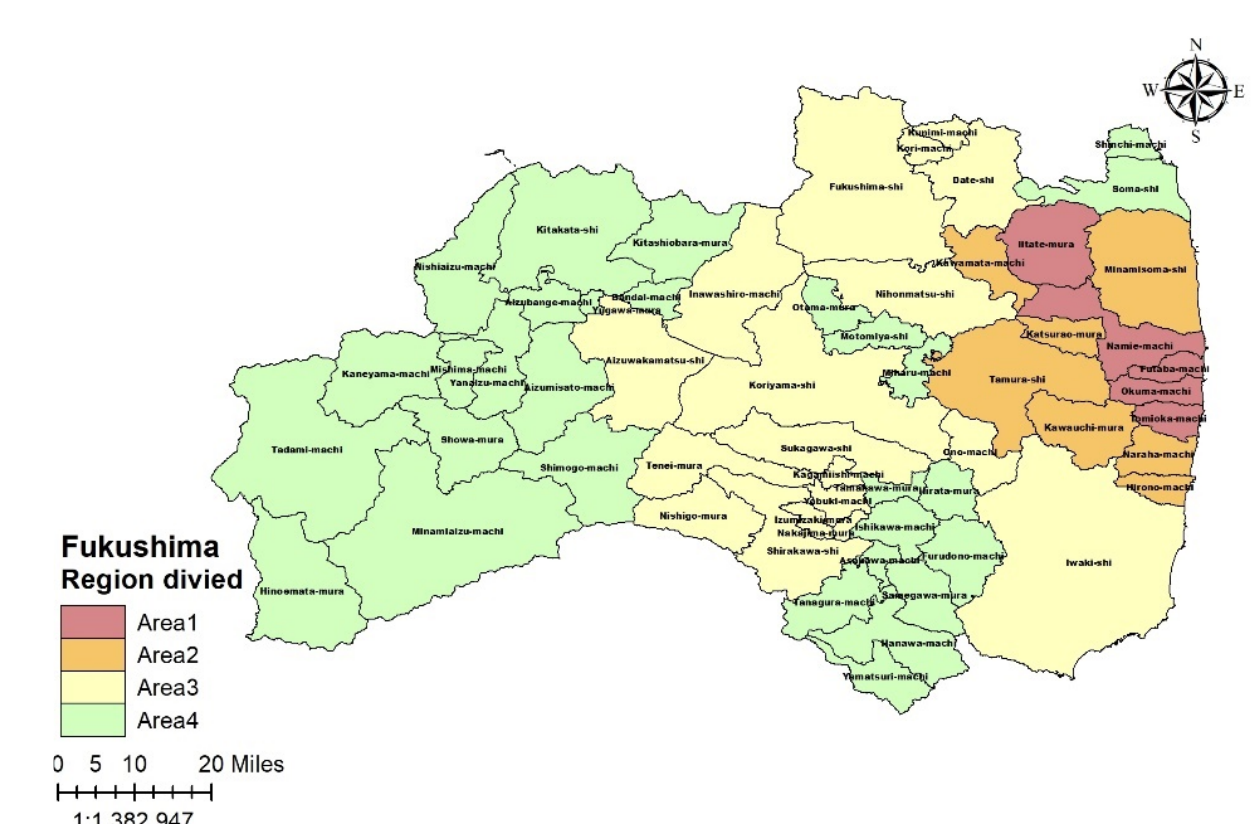
Figure 2. Group design based on the history of the Fukushima evacuation area and caution area. Area 1: still difficult to return at the time of the deadline; Area 2: where the evacuation alerts have been lifted at the time of the deadline; Area 3: near the evacuation area or with a history of voluntary evacuation; and Area 4: all other areas.